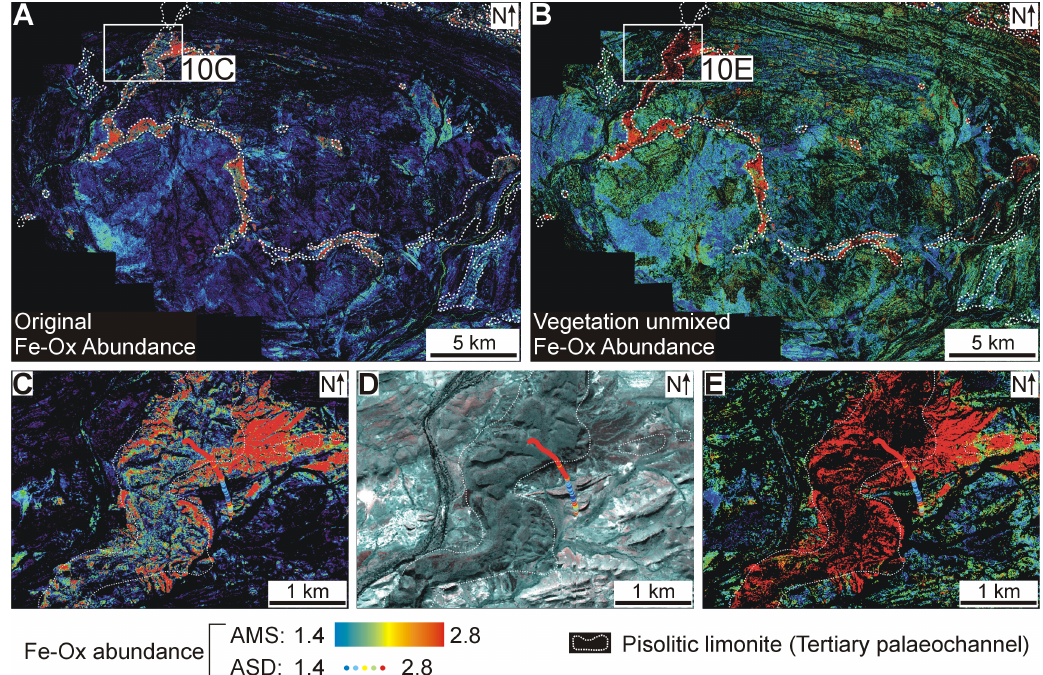
Figure 2. (a–b) Fe-(oxyhydr-)oxide (Fe-Ox) abundance maps of the Rocklea Dome without (a) and with (b) vegetation unmixing. (c–e) Fe- Ox abundance maps of the southern part of the Beasley River CID with (c) and without (e) vegetation removal and the false-colour image of this area (d) . The Beasley River CID has a plateau-like surface expression, with the edges of the plateau clearly visible in the false-colour image. These edges were mapped by the Geological Survey of Western Australia as representing the boundary of the pisolitic limonite (Fe- rich palaeochannel; stippled white line) (the Fe-Ox abundance measurements collected along transects 1 to 7 with the TerraSpec™ are also shown for